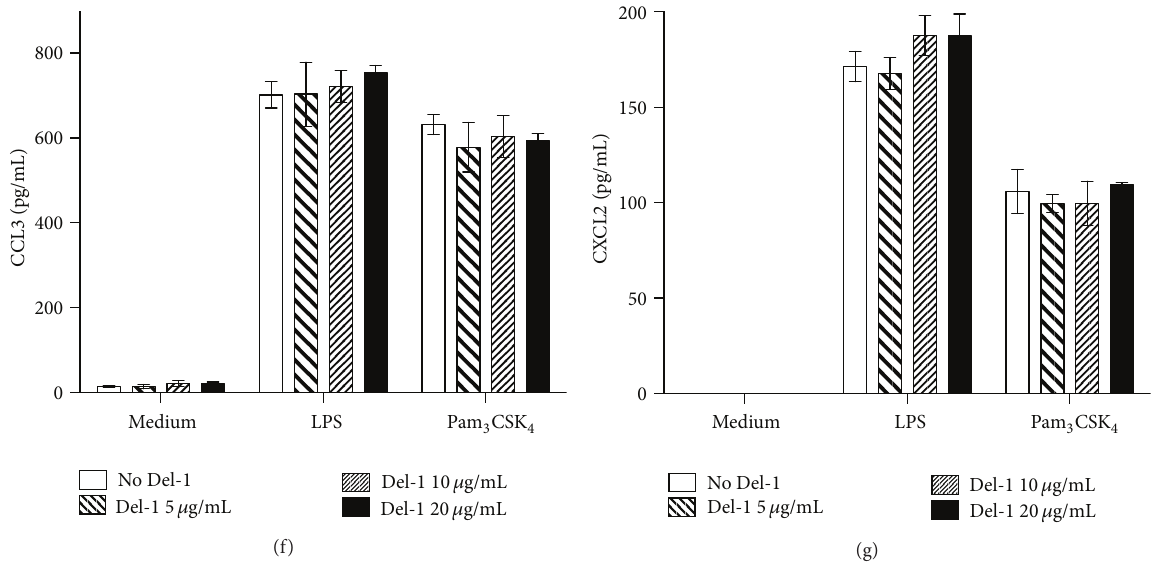
Figure 4: Del-1 inhibits ICAM-1-dependent chemokine production by neutrophils. (a)–(c) ATRA-differentiated HL-60 neutrophils were cultured for 24 hours on plates coated with Fc protein control, ICAM-1-Fc, or Del-1-Fc, and induction of release of CCL3 (a), CXCL2 (b), and TNF (c) was assayed by ELISA. (d)-(e) ATRA-differentiated HL-60 neutrophils were cultured for 24 hours on ICAM-1-Fc-coated plates in the presence of the indicated concentrations of soluble Del-1, and induction of release of CCL3 (d) and CXCL2 (e) was assayed by ELISA. (f)-(g) ATRA-differentiated HL-60 neutrophils were stimulated for 24 hours with 1 𝜇 g/mL Pam 3 CSK 4 or 0.1 𝜇 g/mL LPS, in the absence or presence of the indicated concentrations of Del-1, and induction of release of CCL3 (f) and CXCL2 (g) was assayed by ELISA. Data are means ± SD ((a)–(e), 𝑛 ≥ 4 and(f)-(g), 𝑛 = 2 setsofHL-60cells). ∗ 𝑃 < 0.01